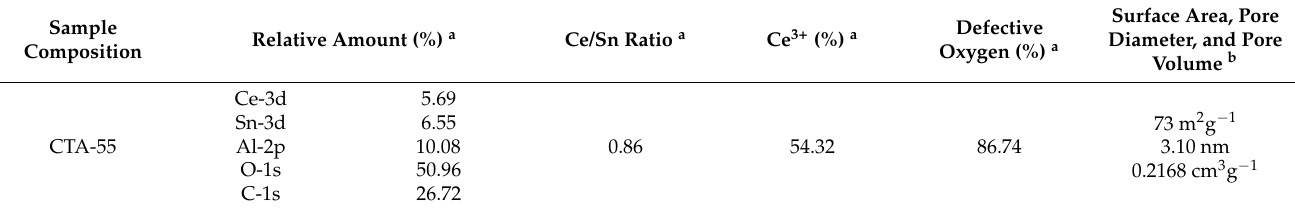
Figure 5. ( a , b ) Nitrogen-sorption isotherm of CTA-55 mixed oxide, ( c ) BJH plot, and ( d ) t-plot.